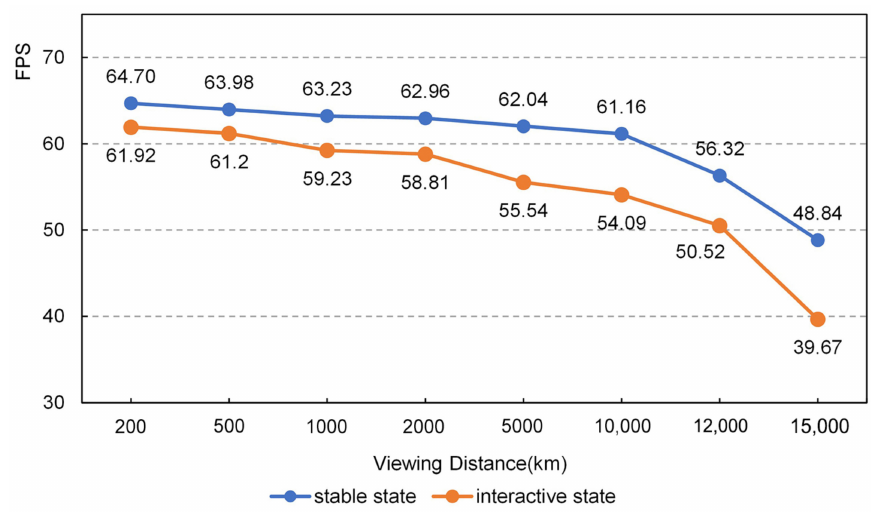
Figure 13. Rendering efficiency with different viewing